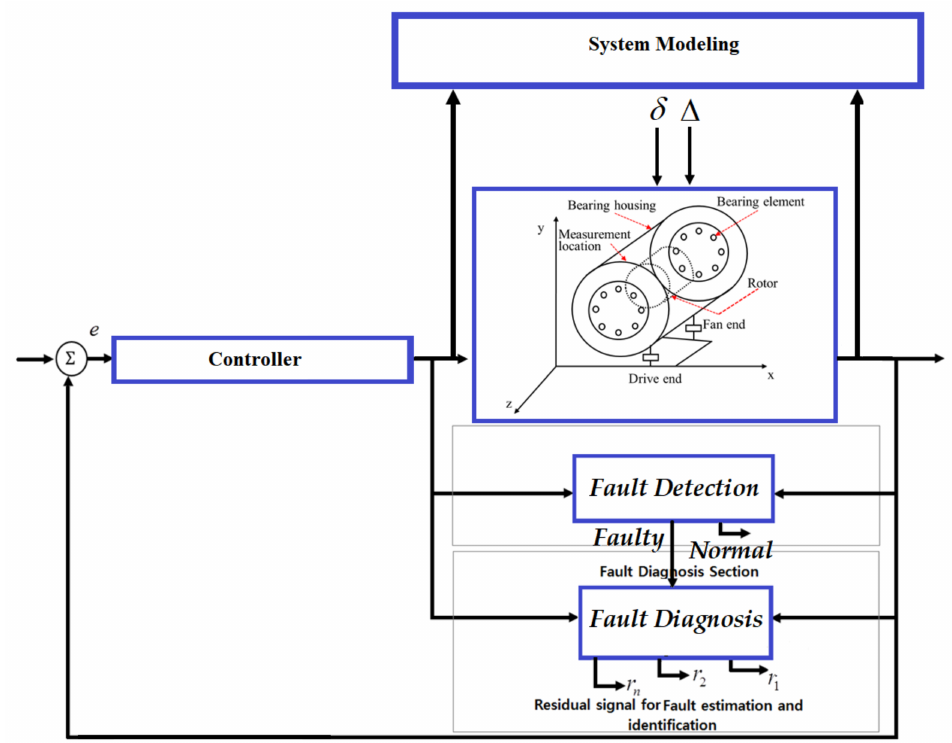
Figure 2. A block diagram of systems, faults, and fault diagnosis and their